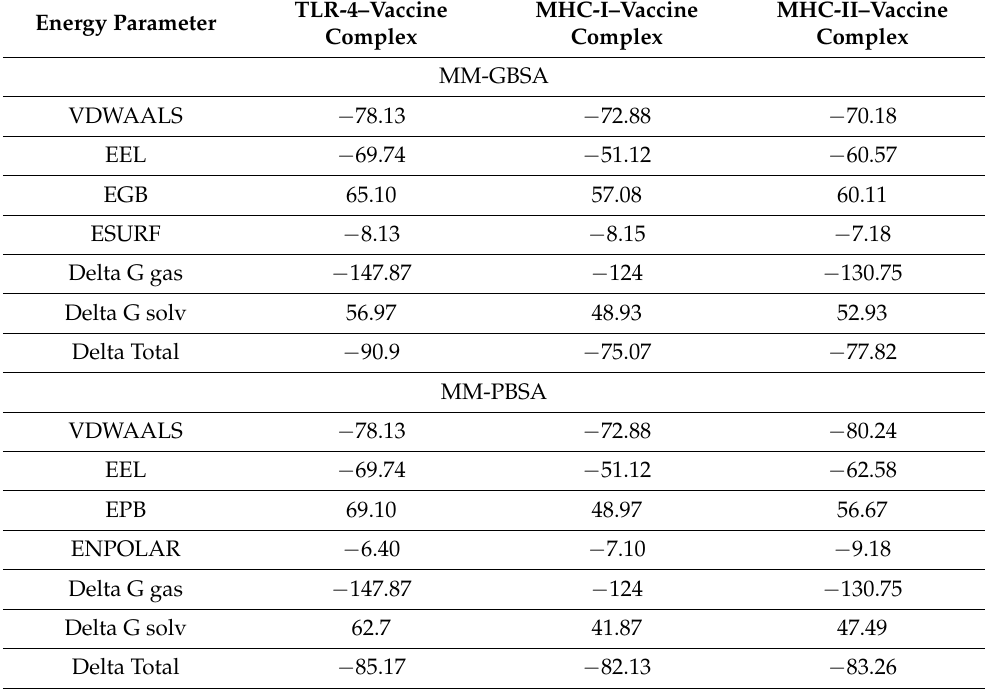
Table 4. MMGBSA/PBSA binding free energies results from the vaccine construct with MHC- I, MHC-II, and TLR4 complexes. The energy values are reported in kcal/mol. TLR-4–Vaccine MHC-I–Vaccine Energy Parameter Complex